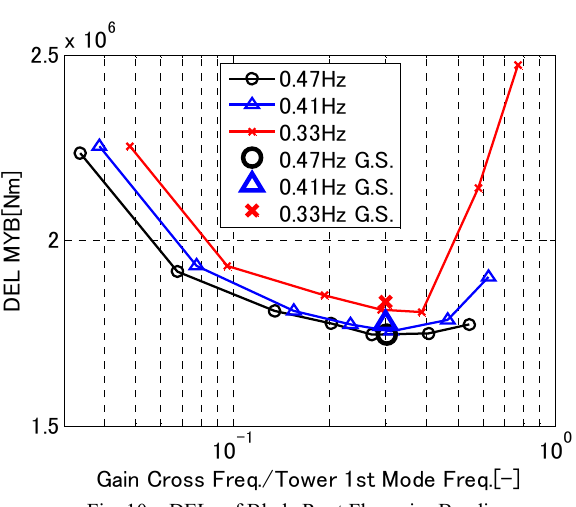
Fig. 10 DELs of Blade Root Flap-wise